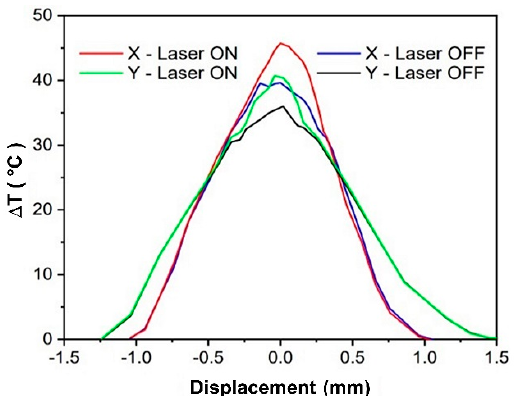
Figure 3. Temperature spatial profiles, as detected by the TP T sensor during Y scan of a hot wire in the focal plane with laser OFF (black) and ON (green), and along X scan with laser OFF (blue) and ON (red).